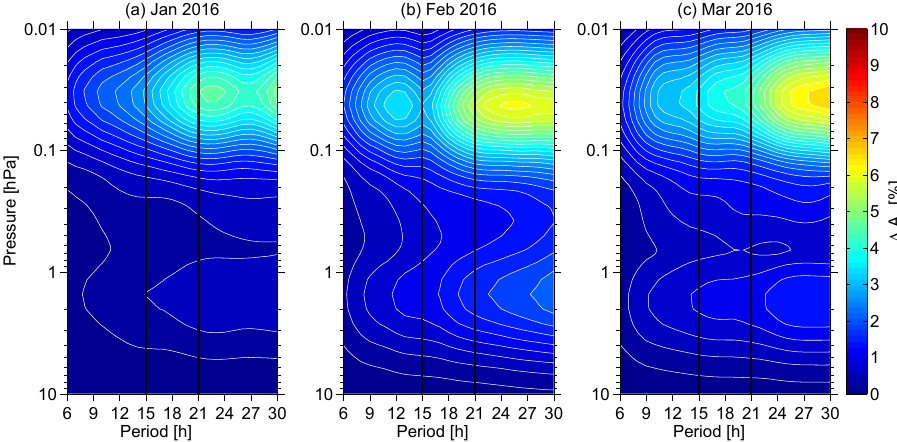
Figure 11. Spectral analysis of the a priori contribution in the MIAWARA water vapor retrievals for periods between 6 and 30h. Shown are monthly mean absolute wave amplitudes of the a priori contribution A c (in %) for January (a) , February (b) and March (c)